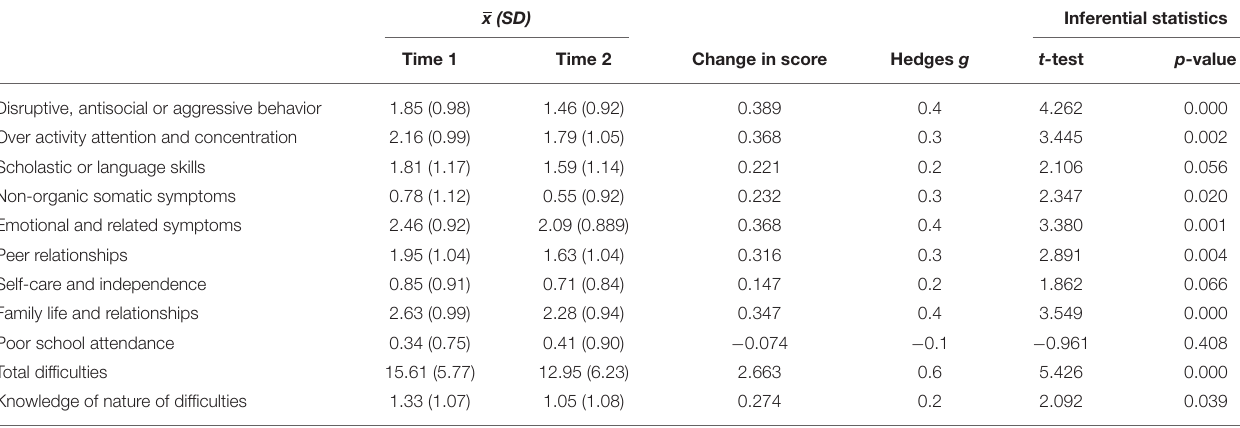
TABLE 3 | Change over time as measured by the HoNSOCA ( n = 91).